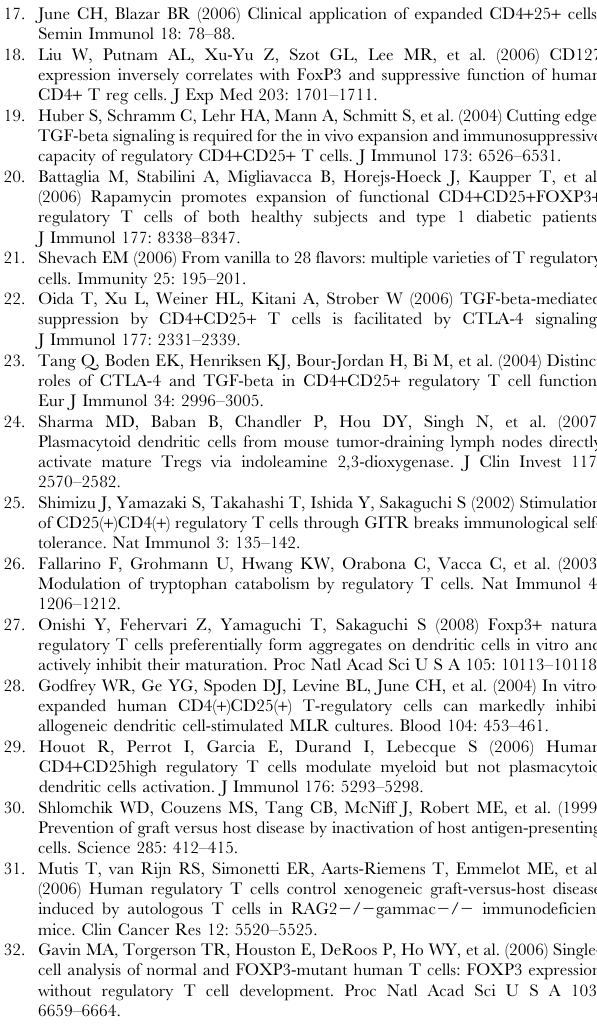
Figure S2 Human T cell numbers in vivo: role of ex vivo T cell activation. Rag2 2 / 2 c c 2 / 2 mice were reconstituted with human cells, as indicated, including: PBMC alone (‘‘PBMC’’), purified lymphocytes plus either monocytes (‘‘Lymph + mono’’) or